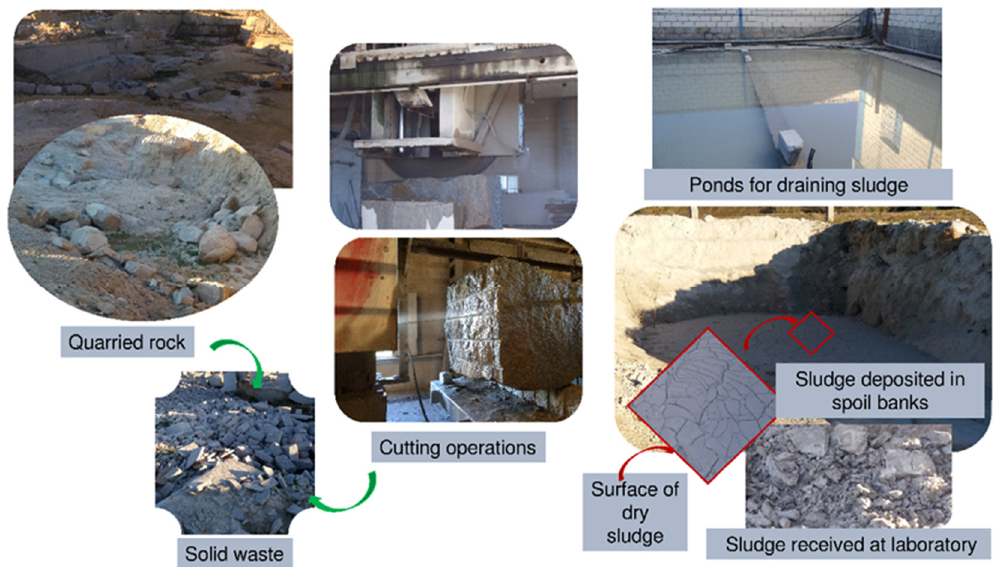
Figure 1. Ornamental granite production and waste generated.